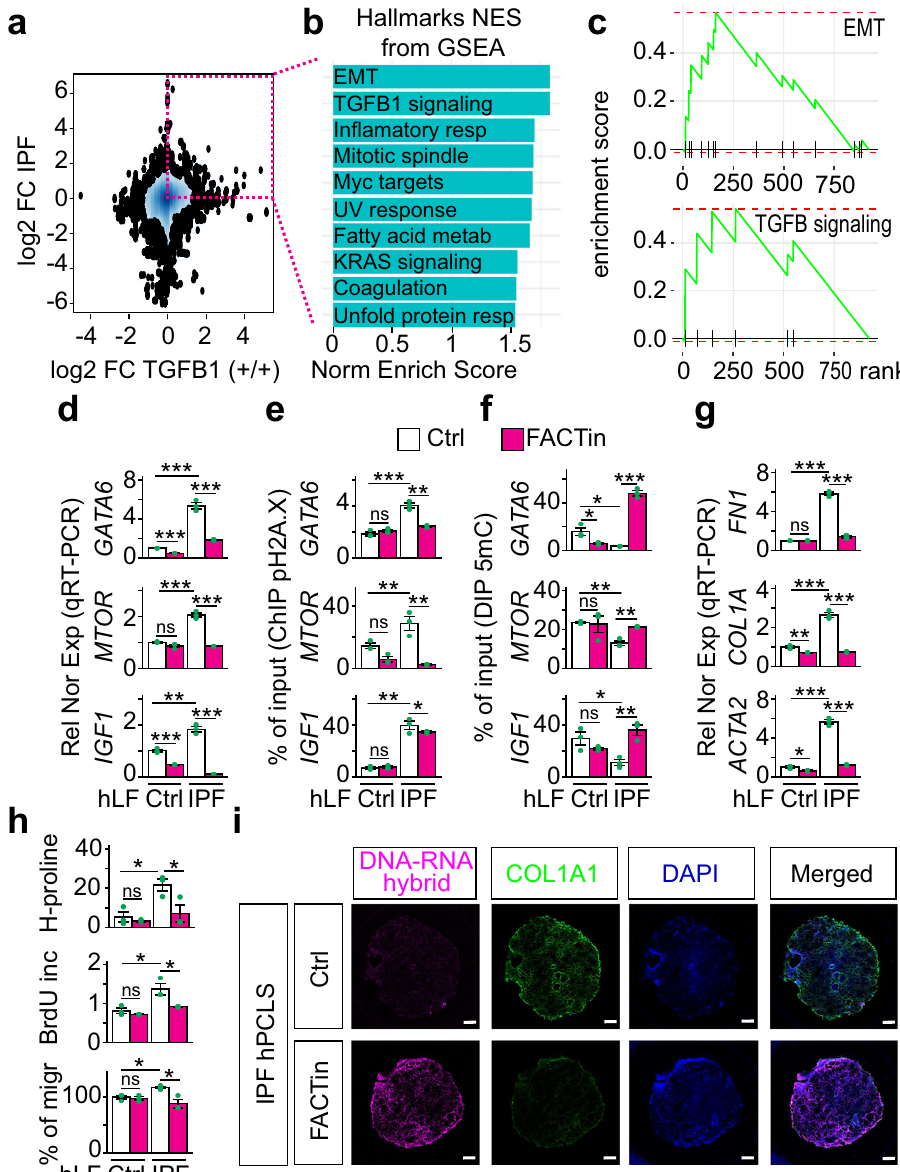
Fig. 9 Inhibition of the FACT complex counteracts fi brosis hallmarks in IPF. a RNA-seq-based comparison of gene expression in IPF and after TGFB1 treatment. 2D Kernel Density plot representing the log2 fold change between gene expression in primary human lung fi broblasts (hLF) from IPF patients vs. control donors on the y -axis and log2 fold change between gene expression in Hmga2 + / + MEF treated with TGFB1 vs. non-treated on the x -axis. Square, genes with log2 FC > 0.58 and P ≤ 0.05 in both, hLF IPF and TGFB1-treated MEF. P -values after Wald test. b Gene set enrichment analysis (GSEA) using the normalized enrichment scores (NES) of genes inside the square in a. EMT, epithelial-mesenchymal transition; resp, response. c GSEA line pro fi le of the top two enriched pathways in b . d qRT-PCR-based expression analysis of selected HMGA2 target genes in hLF from control donors (Ctrl) or IPF patients that were non-treated (Ctrl) or treated FACT inhibitor (FACTin; CBLC000 tri fl uoroacetate) as indicated. e ChIP-based promoter analysis of selected HMGA2 target genes using pH2A.X-speci fi c antibodies and chromatin from hLF treated as in d . f DIP-based promoter analysis of selected HMGA2 target genes using 5mC-speci fi c antibodies and genomic DNA from hLF treated as in d . g qRT-PCR-based expression analysis of fi brotic markers in hLF treated as